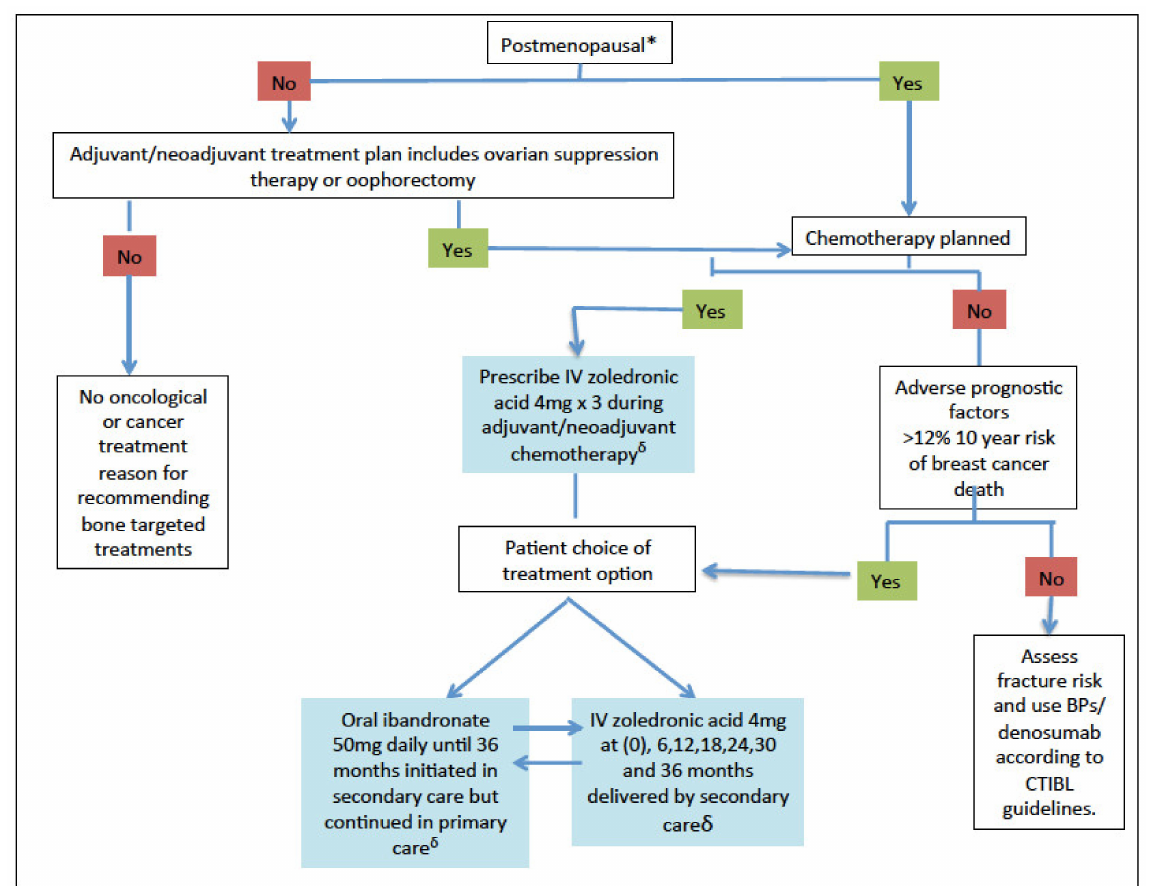
Figure 1. Algorithm for the use of adjuvant bisphosphonates in patients # with early breast cancer. Adapted with permission from ESMO guidelines on bone health from Ref. [21], 2020, Annals of Oncology, Elsevier. * If not clinically assessable, i.e., hysterectomy/IUD, then ensure age > 55+/or serum FSH is in postmenopausal range (patient must not be receiving concurrent therapies that can affect the hypophyseal pituitary gonadal axis). # Patients already on weekly oral bisphosphonates for osteoporosis should be considered for a treatment change and follow algorithm. δ Include vitamin D 800–2000 IU (+calcium 1000 mg daily if low calcium diet). CTIBL, cancer therapy induced bone